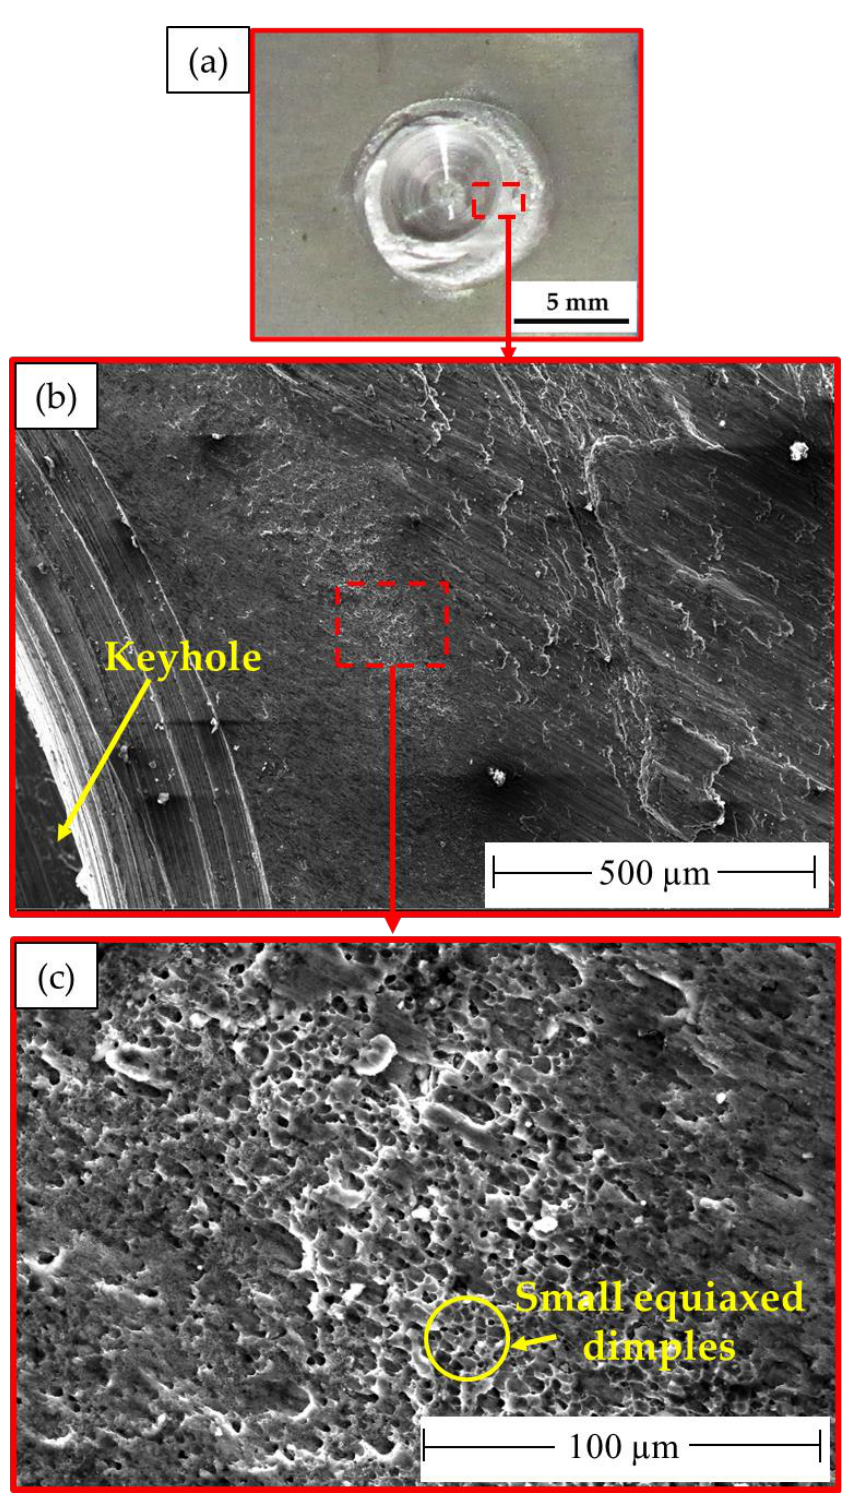
Figure 13. ( a ) Photograph of the top surface of the lower sheet of the joint FSSWed at 1 s and 500 rpm after tensile test and ( b , c ) different magnifications of SEM images showing the fracture surfaces of the failed joint. Note: dotted red lines enclosed area indicating where the micrographs were taken.